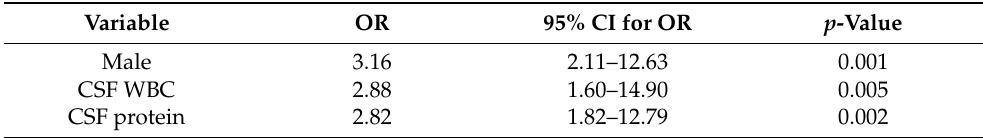
Table 5. Logistic regression analysis with outcomes as the dependent variable (R 2 = 0.68). OR, odds ratios; CI, confidence interval; cerebrospinal fluid; WBC, white blood cell;